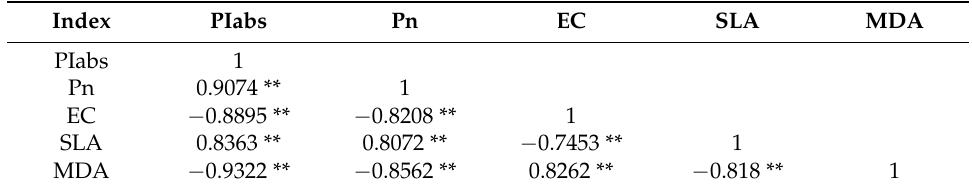
Table 2. Correlations among (PIabs, net photosynthetic rate, electrolyte leakage, specific leaf area, malondialdehyde) of 20 genotypes measured at 25/18 ◦ C d/n.